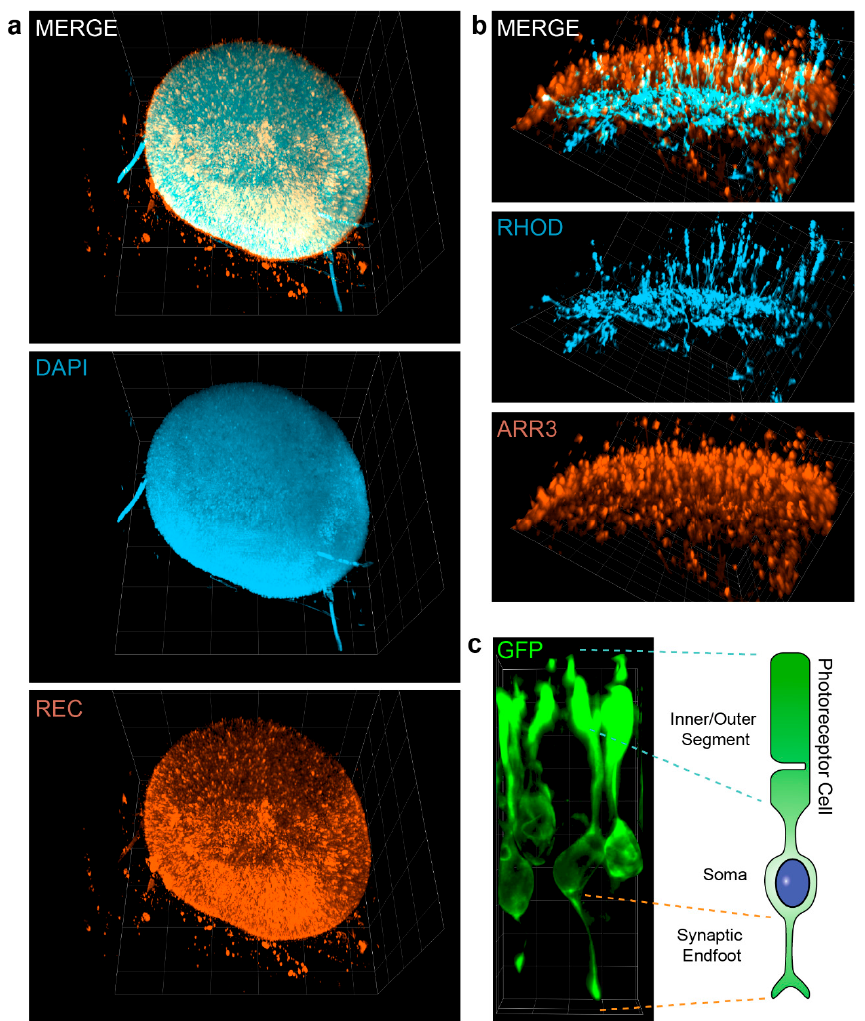
Figure 3. Visualization of photoreceptor morphology. ( a ) Three-dimensional rendered image of a cleared whole retinal organoid (day 182) based on a light sheet image stack. Retinal organoids were stained for DAPI (nuclei staining, light blue) and Recoverin (REC, pan-photoreceptor marker, orange). ( b ) Three-dimensional rendered image of a day 260 cleared retinal organoid stained for the rod marker Rhodopsin (RHOD, light blue) and the cone marker Arrestin 3 (ARR3, orange). ( c ) Day 182 cleared retinal organoid transfected with a lentiviral vector labeling photoreceptor cells (pJG-IRPB-eGFP) and counterstained by a GFP-antibody. Image was 3D rendered from a small stack that was excised from a light sheet-acquired image. Grid square side length in rendered 3D images: ( a ) 200 µ m, ( b ) 40 µ m, and ( c ) 9.3 µ